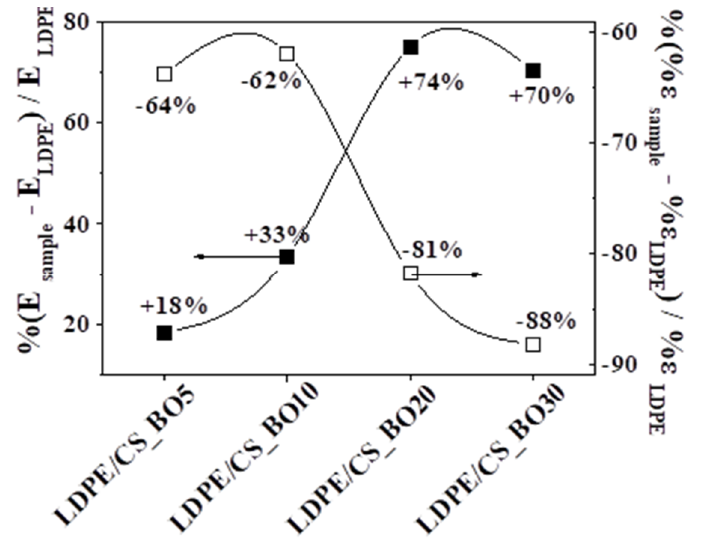
Figure 7. % variation of mean values of the Young’s Modulus–E values, and of the mean values of the %elongation at break–%ε values for all tested the LDPE/CS_BO active packaging films.